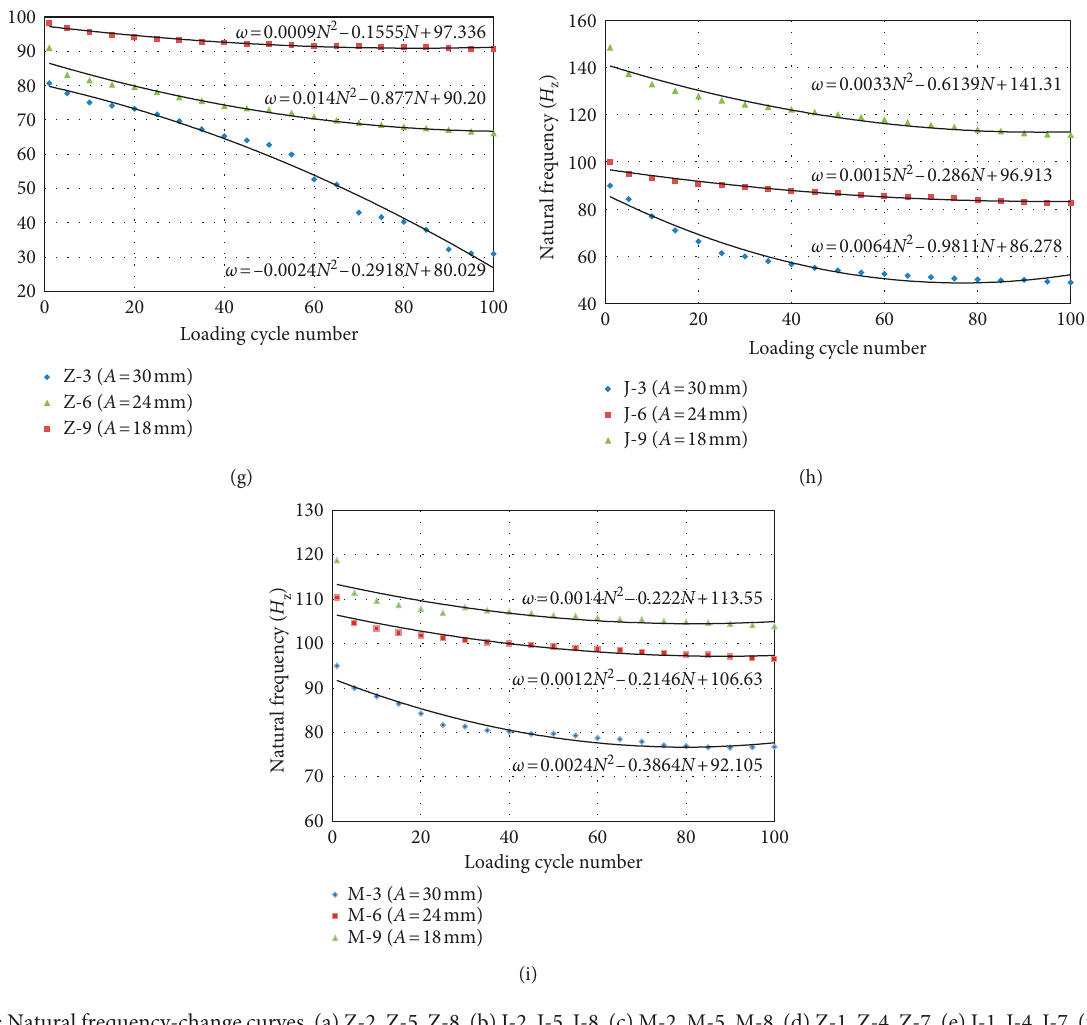
Figure 11: Natural frequency-change curves. (a) Z-2, Z-5, Z-8. (b) J-2, J-5, J-8. (c) M-2, M-5, M-8. (d) Z-1, Z-4, Z-7. (e) J-1, J-4, J-7. (f) M-1, M-4, M-7. (g) Z-3, Z-6, Z-9. (h) J-3, J-6, J-9. (i) M-3, M-6,